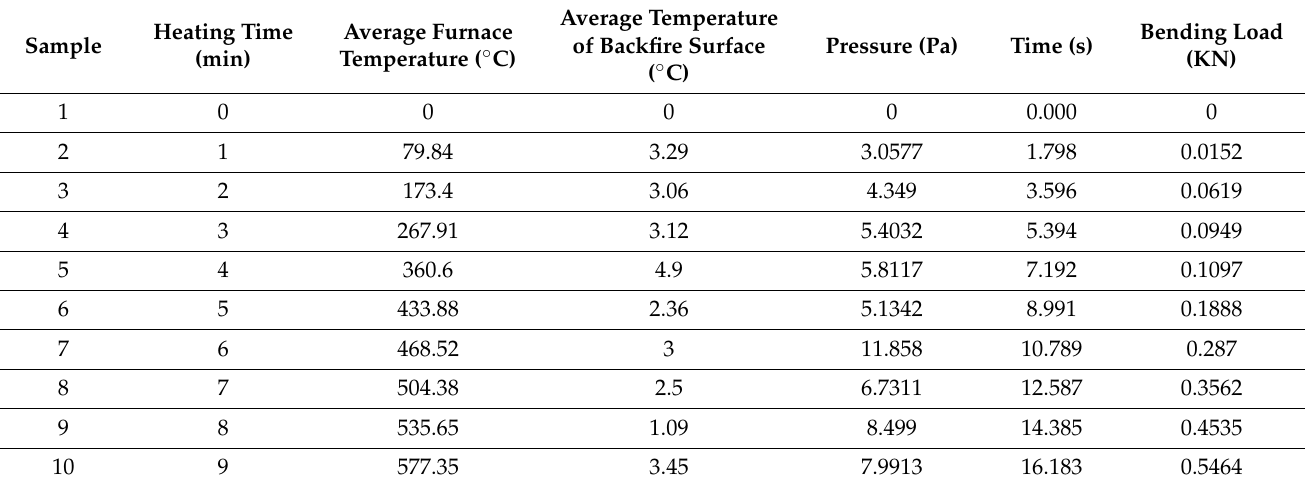
Table A1. Fire resistance and stress performance data of the